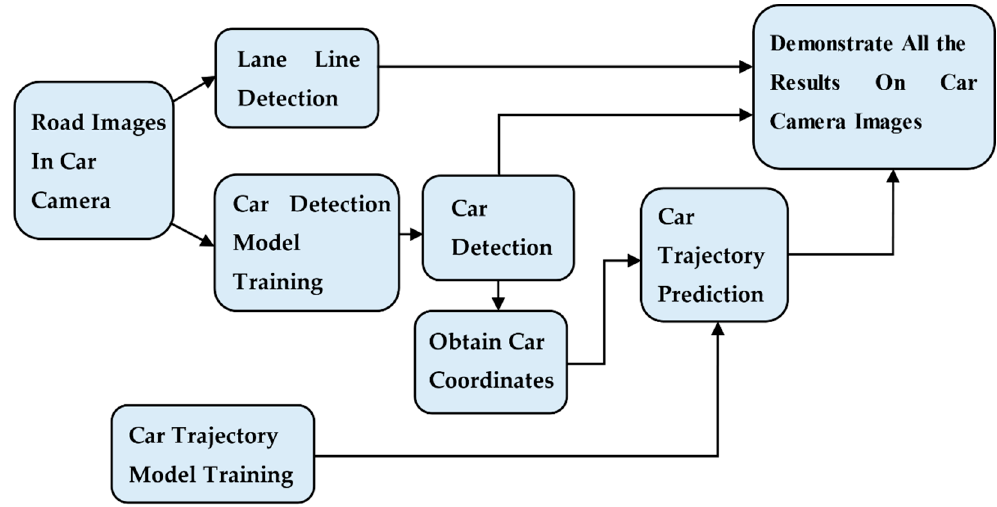
Figure 1. The proposed framework of this research, which is composed of car detection, lane line detection, and car trajectory prediction.